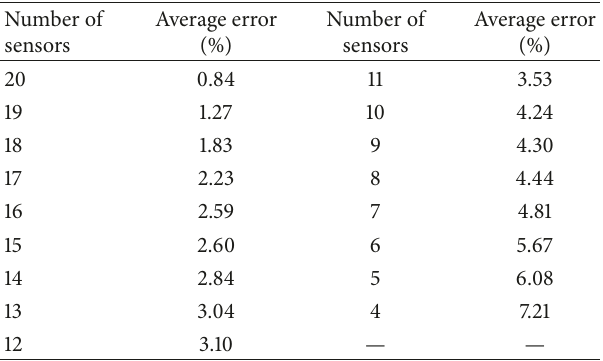
Table 3: Mean value of error with different numbers of sensors. Number of sensors